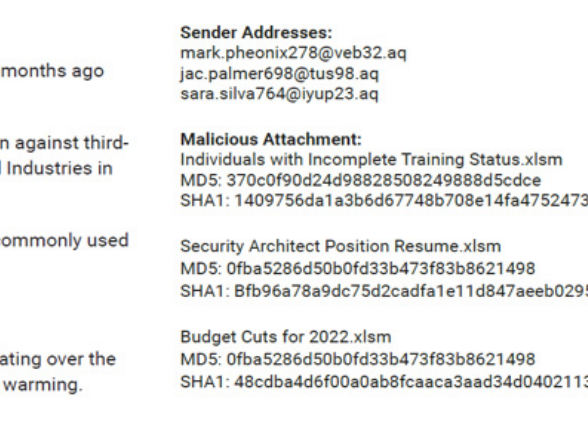
Figure 1. An example of threat Intelligence Report summary.